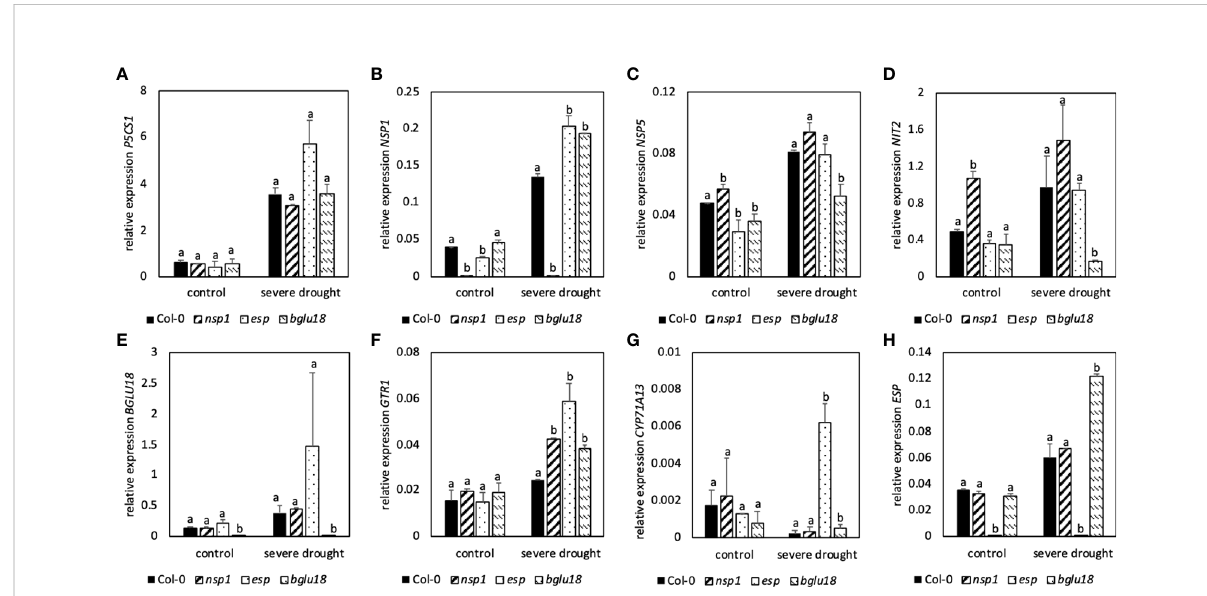
FIGURE 7 Relative expression of genes involved in stress response (P5CS1, A), glucosinolate breakdown (NSP1, B; NSP5, C; ESP, H; BGLU18, E), transport (GTR1, F) and synthesis of indole-3-acetic acid (NIT2, D;CYP71A13, G) to the reference gene EF1 a . Plants were subjected to 40% PEG 20,000 (severe drought stress) for 7 days. Plants were grown on petri dishes for fi ve weeks prior to application of drought stress. Bars represent means of three biological replicates consisting of four pooled plants each. Different letters indicate signi fi cant differences (p<0.05) between Col-0 and mutant